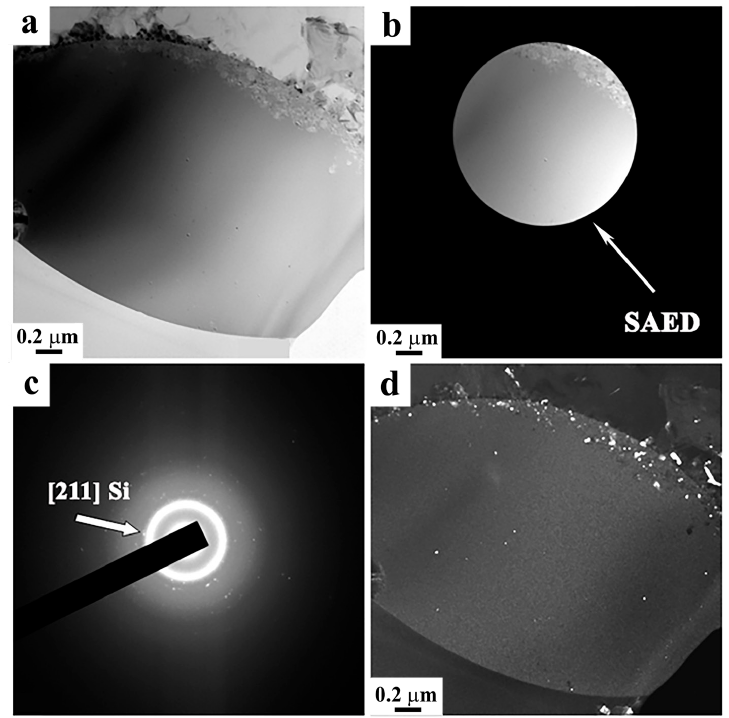
Figure 5. Electron microscopic image of Al-11wt%Si alloy’s surface layer structure subjected to electroexplosion alloying and subsequent irradiation by pulsed electron beam; a - bright fields and b - bright fields with SAED; c - selected area electron diffraction (the arrow designates the reflection of dark field formation); d - dark field formed in reflection [211] of Si.